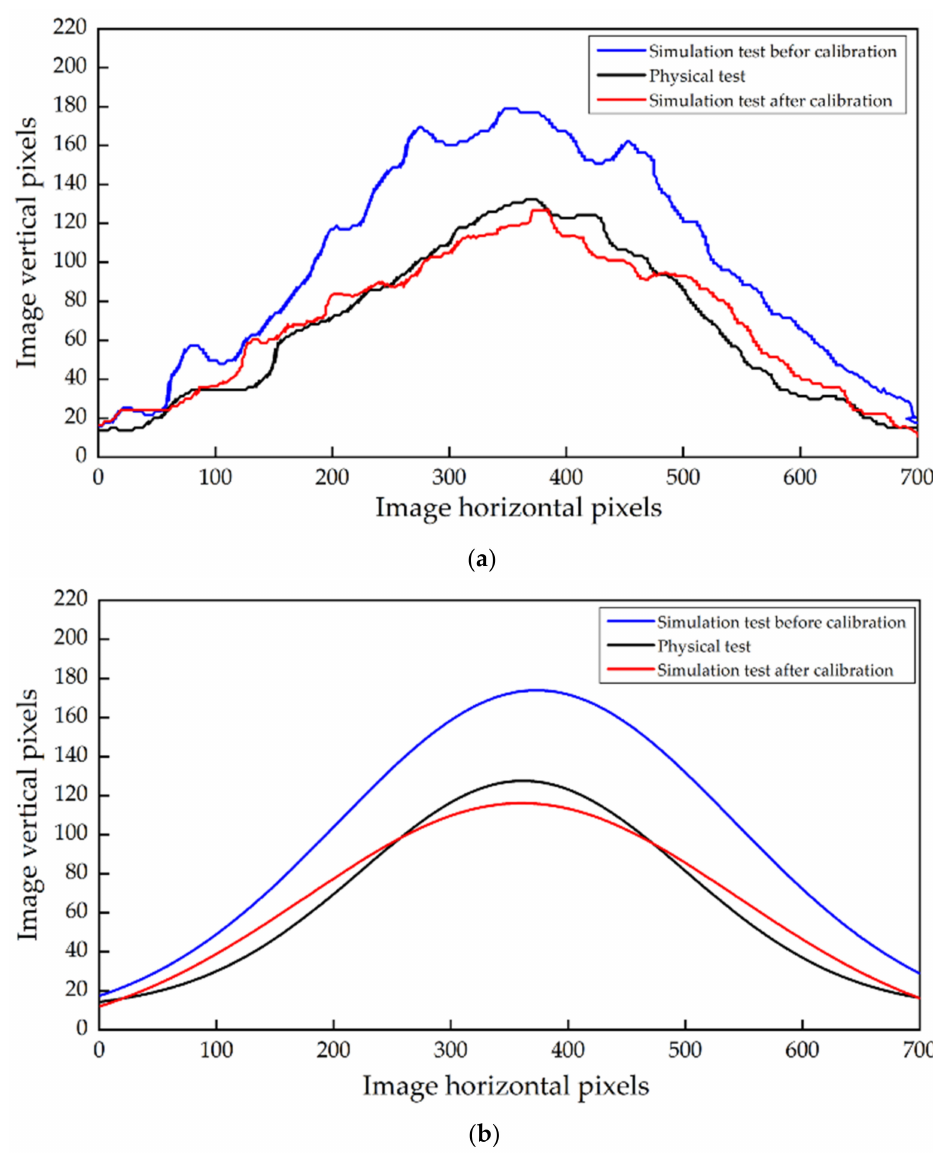
Figure 16. Comparison of the simulated and actual MRSM stack. ( a ) Contour comparison; and ( b ) Fitted curve comparison. Table 11. Results of rotating drum test for